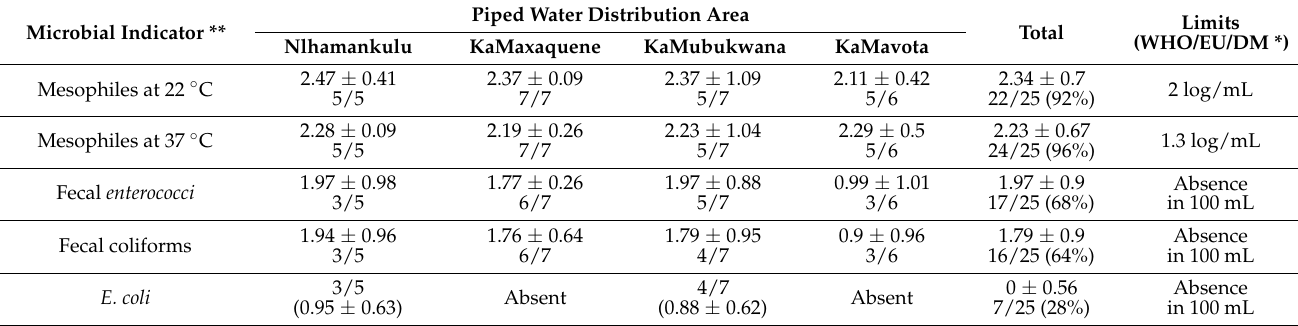
Table 3. Evaluation of piped water (tap water) in four municipal districts of Maputo, according to each microbial indicator for drinking water. Number of samples with contamination higher than the limits and total percentage (%) are indicated. Microbial Indicator